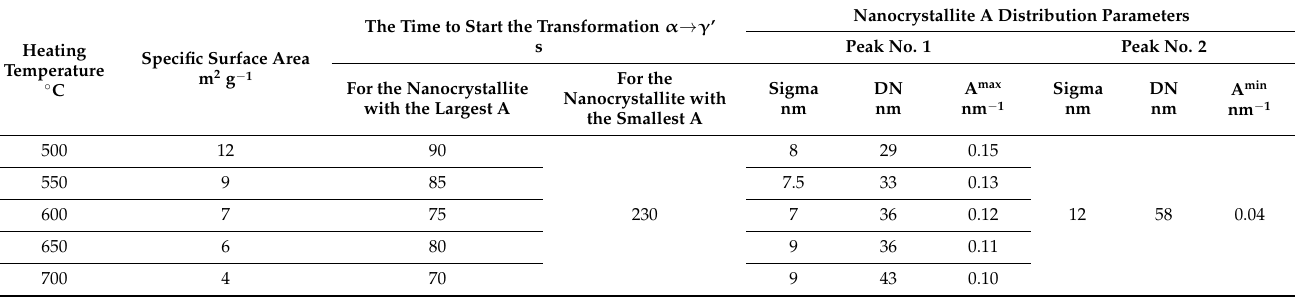
Heating Temperature ◦